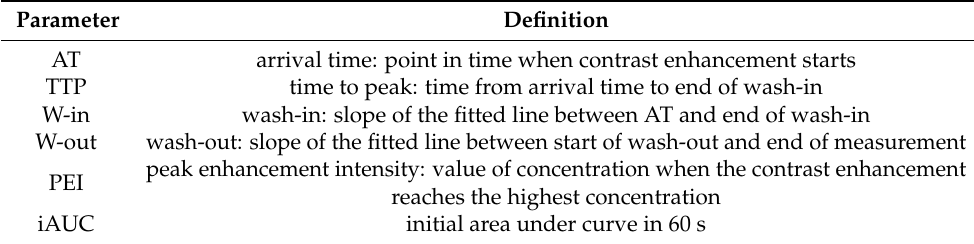
Table 7. Definition of DCE-MRI